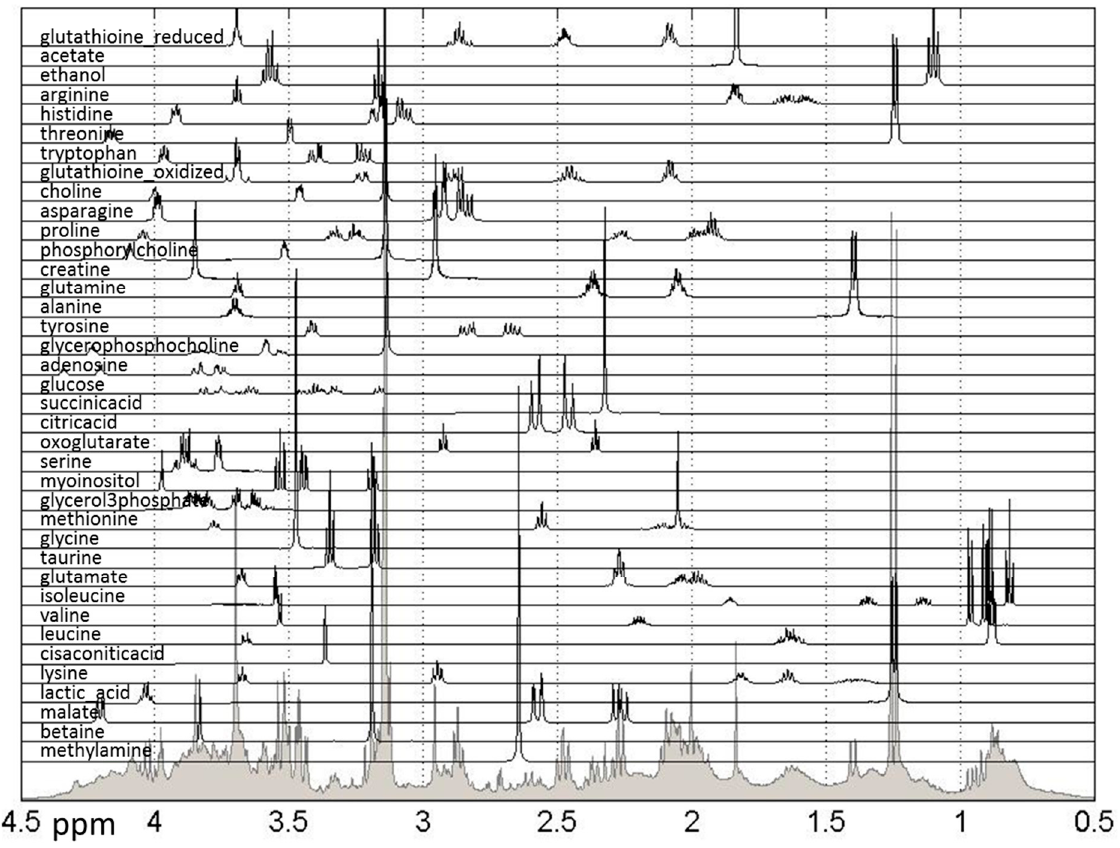
Figure 5. Reference spectra of metabolites used for quantification of relative concentrations of hydrophilic metabolites measured in NMR spectra. Shown are all quantified metabolites as well as the sum of NMR spectra for all samples. The spectral range from 0.5 to 4.5 ppm is shown, however the spectral range used for quantification was 0.5–9 ppm.